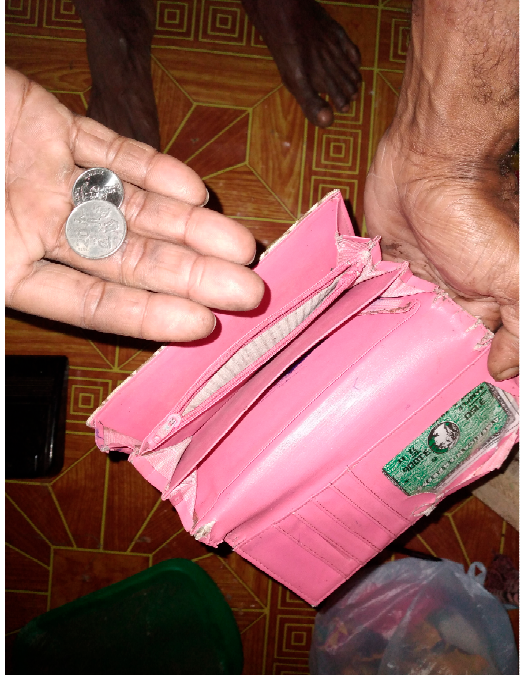
Figure 3. Ceasing employment to provide care. Photo caption: “My wife and I decided that I would no longer work and that I would prioritise looking after the children and my sister. However, this has not only affected my nuclear family but also my mum and dad because they have the same needs as [my sister]—diapers and pads”. Photo credit: Nick.